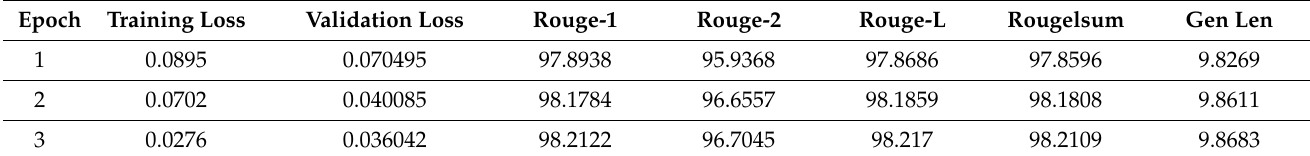
Table 9. Training process and results of Q2S after augmentation (on